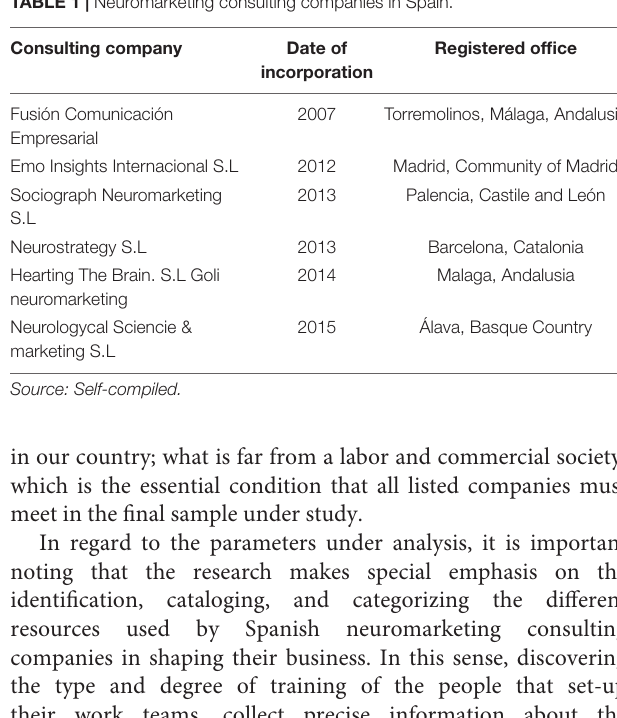
TABLE 1 | Neuromarketing consulting companies in Spain.